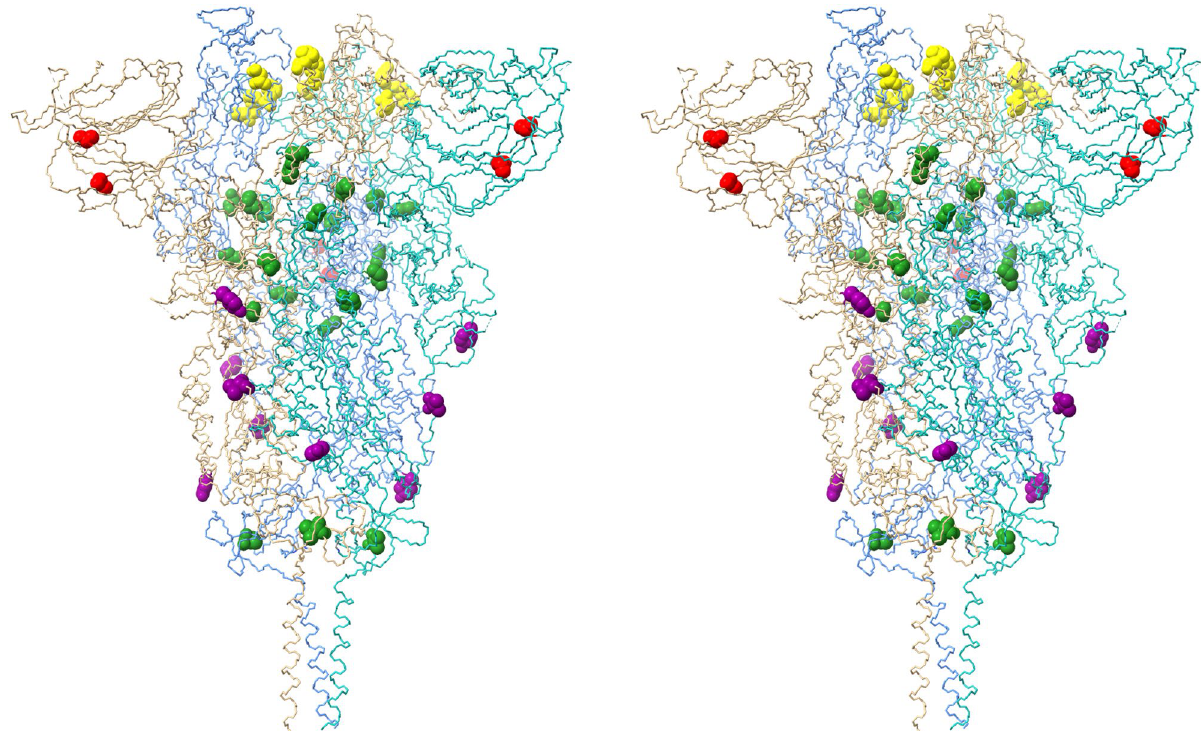
Figure 6. Stereo pair view of spike protein receptor trimer illustrating the locations of all Omicron spike protein mutations (excepting RBD contact surface mutations present in Fig. 5). Monomer A is blue, monomer B is salmon and monomer C is aquamarine. All mutated residues are rendered as CPK models. Yellow residues (S371L, S373P, S375F, K417N) are located in the RBD where they may alter domain packing and/or monomer– monomer interactions. Green residues (T547K, N764K, N856K, Q954H, N969K, L981F, I1081V) are located at or near monomer–monomer interfaces in the receptor trimer assembly. Red residues (A67V, T95I) are located in the interior of the N-terminal domain. Purple residues (N655Y, A701V, D796Y) are located on the exterior surface of the trimer assembly in regions that are potential antibody binding sites. The homology model is